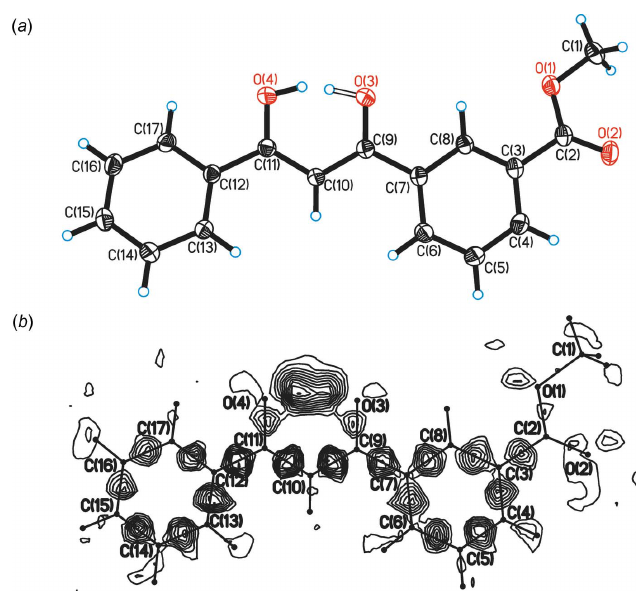
Figure 1 ( a ) Molecular structure of 3-(3-hydroxy-3-phenylprop-2-enoyl)benzoate. Displacement ellipsoids are shown at the 50% probability level; ( b ) difference-density map in the plane of the hydrogen-bonded ring. This map was computed after least-squares refinement without the hydrogen atoms H21 and H22 involved in the hydrogen bond. Contours are drawn at 0.04 e A˚ (cid:5) 3 intervals.